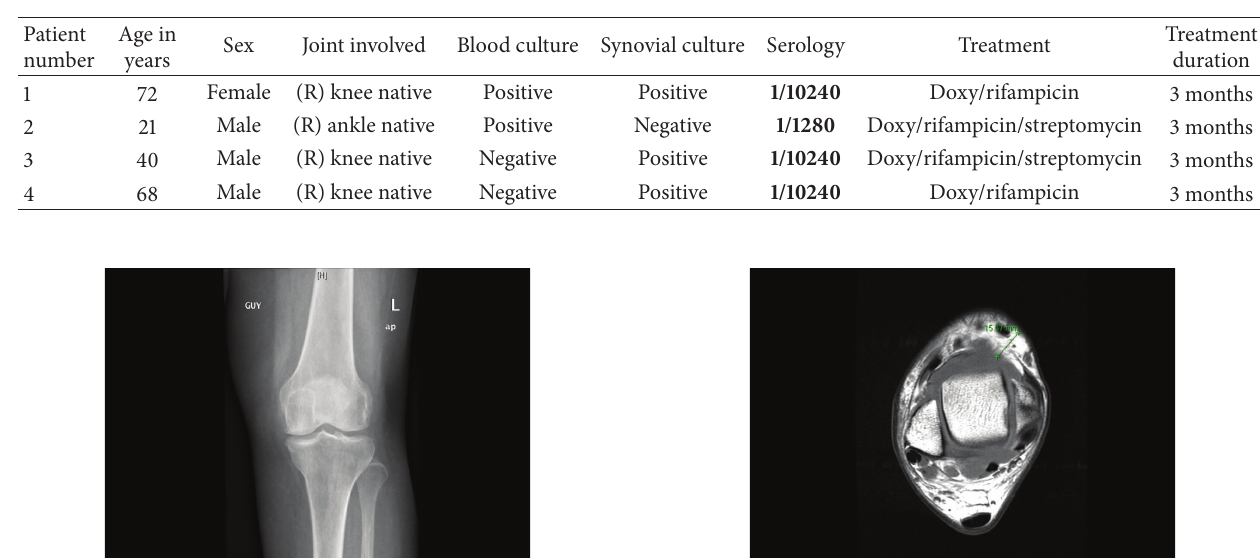
Table 1: Summary of microbiology, serology findings, and the treatment of the patients.